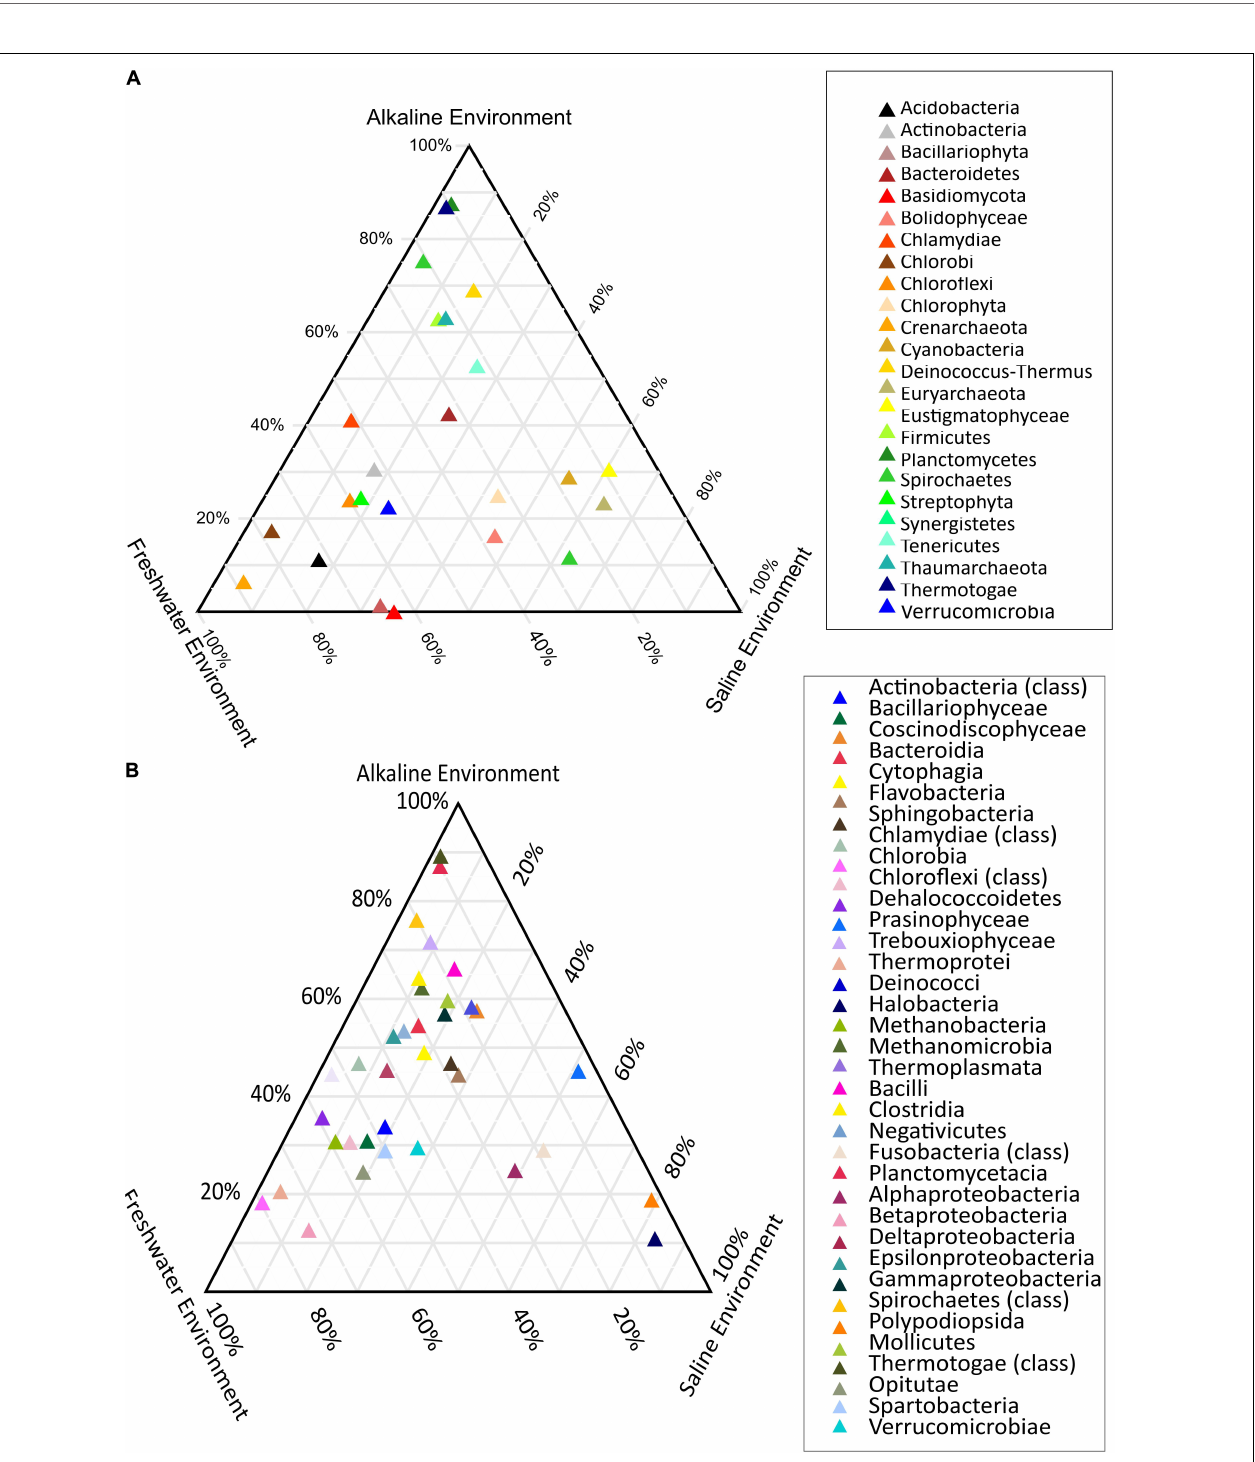
primarily focused on the isolation of microbial cultures (Bhatt et al., 2016), while a few were focused on assessing its microbial diversity (Sharma et al., 2013). These studies were limited